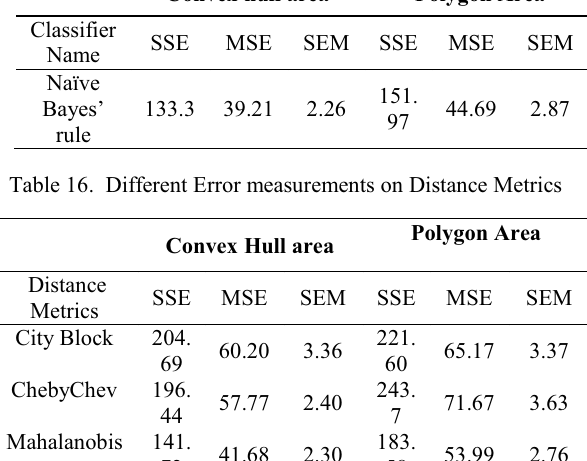
Table 15. Different Error measurements on Naïve Bayes’ rule